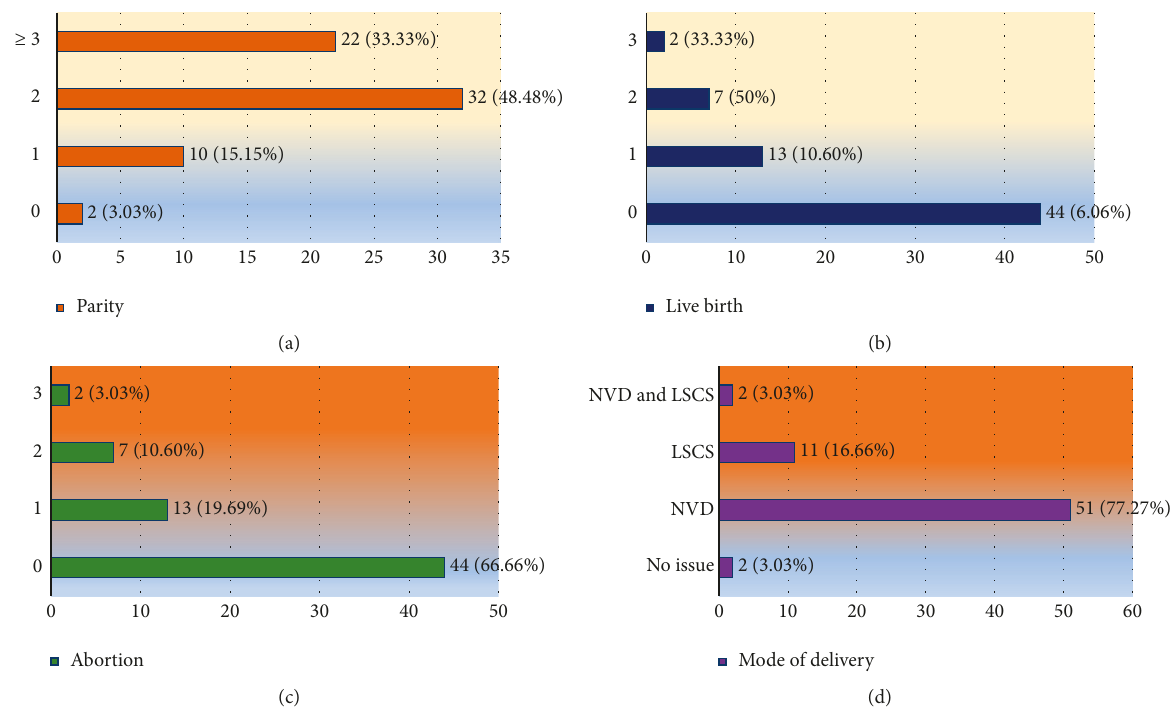
Figure 4: Obstetrics history of participants with abnormal vaginal discharge. (a) Parity. (b) Live birth. (c) Abortion. (d) Mode of